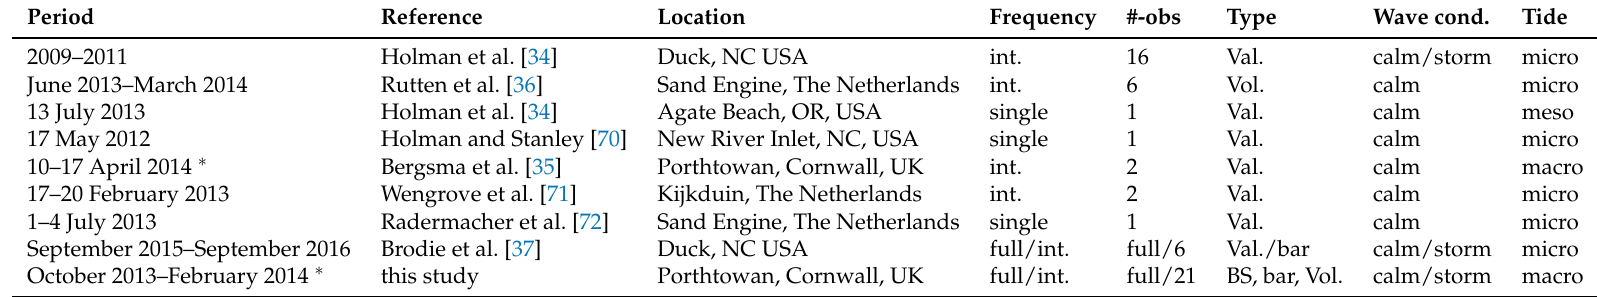
Table A3. Previous cBathy applications. Abbreviations for the Frequency column: single: single estimate, intermittent: int. and full: a bathymetry every for all possible collections (at Porthtowan this means hourly). For the Type column the abbreviations are, Validation: Val., Volume analysis: Vol., Bar tracking: bar and Beach state analysis: